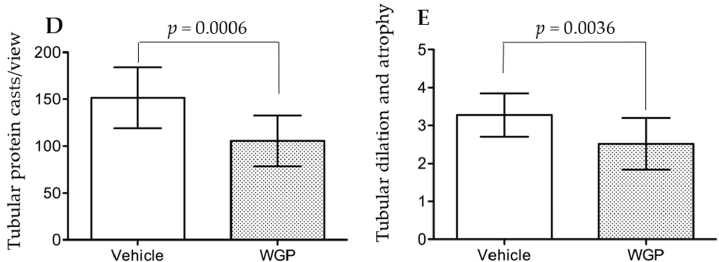
Figure 4. Daily intake of WGP reduces kidney injury in obese diabetic ZSF1 rats. At the end of six months of dietary supplements, six kidneys/rats were randomly selected from each group (Vehicle vs. WGP), and kidney sections were stained with either hematoxylin and eosin (HE) or Periodic acid ‐ Schiff (PAS). ( A ) Typical microscopic images of renal cortex, outer medulla and a glomerulus in each group (Vehicle: top panel; WGP: bottom panel); data showed the same area of renal cortex and outer medulla stained with either HE or PAS. PC: protein cast formation; black stars (*): damaged glomerulus (glomerular atrophy); arrows: PAS ‐ stained mesangial expansion; ( B ) The glomerular atrophy was scored in at least 20 randomly selected views in two separate sections of each kidney, and was presented in average per view; data are presented as mean ± SD of each group ( n = 9); vehicle vs. WGP: p = 0.0225 (two ‐ tailed t ‐ test); ( C ) The mesangial expansion was determined using a 0 to 4 scale based on the percentage of the area stained strongly with PAS; a range of 180 to 250 glomeruli were counted and averaged for each kidney. Data are presented as mean ± SD of each group ( n = 9); vehicle vs. WGP: p < 0.0001 (two ‐ tailed t ‐ test); ( D ) The number of intratubular protein cast formation in each microscopic view was counted in HE ‐ stained section, and the average number of at least 20 randomly selected views under 40× magnification represented in each kidney; data are presented as mean ± SD of each group ( n = 12); vehicle vs. WGP: p = 0.0006 (two ‐ tailed t ‐ test); ( E ) Tubular dilation and atrophy were determined using a 0–4 scale based on the percentage of damaged tubules occupying an area in each microscopic view; the average of at least 30 randomly selected views under 200× magnification represented the tubular atrophy in each kidney; data are presented as mean ± SD of each group ( n = 12). Vehicle vs. WGP: p = 0.0036 (two ‐ tailed t ‐ test).